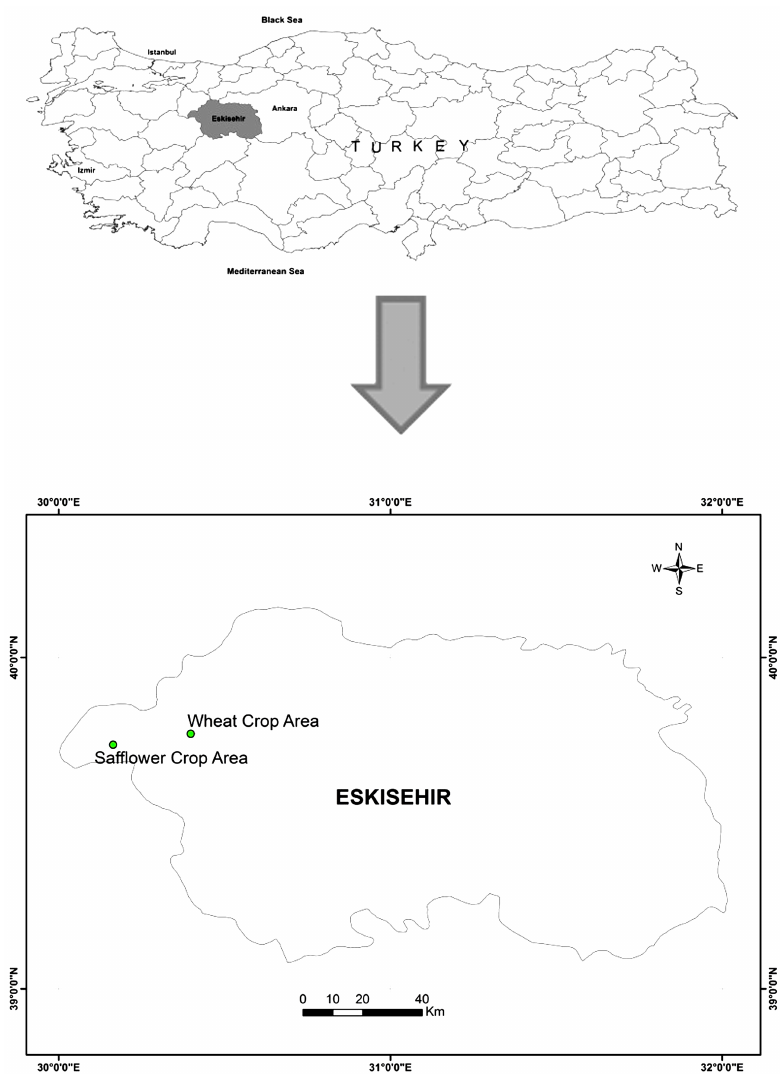
Figure 1. The locations of studied